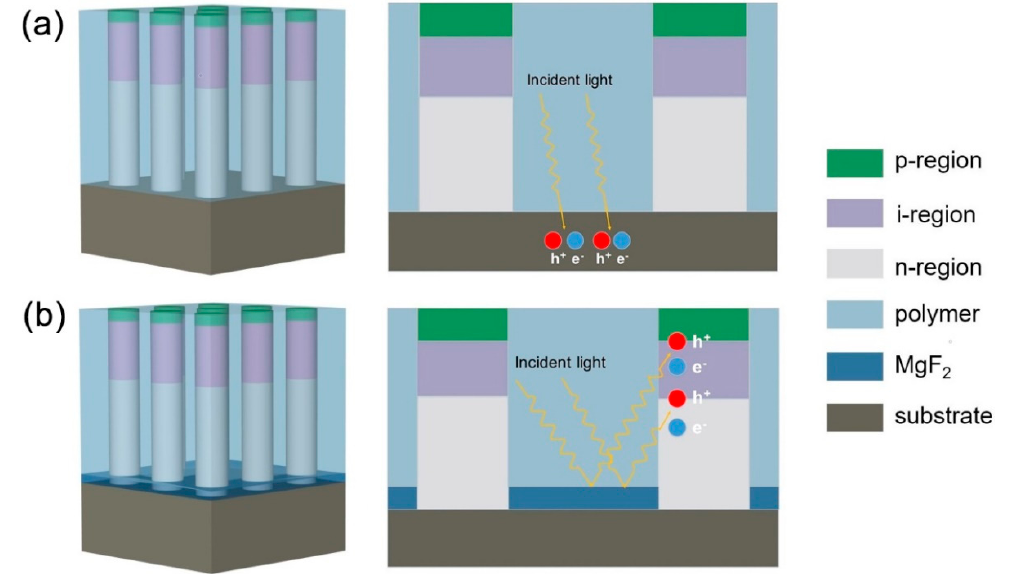
Figure 1. Schematic diagrams of the ( a ) nanowire arrays (NWA) and ( b ) bottom reflectivity enhancement (BRE-NWA) solar cell structures.